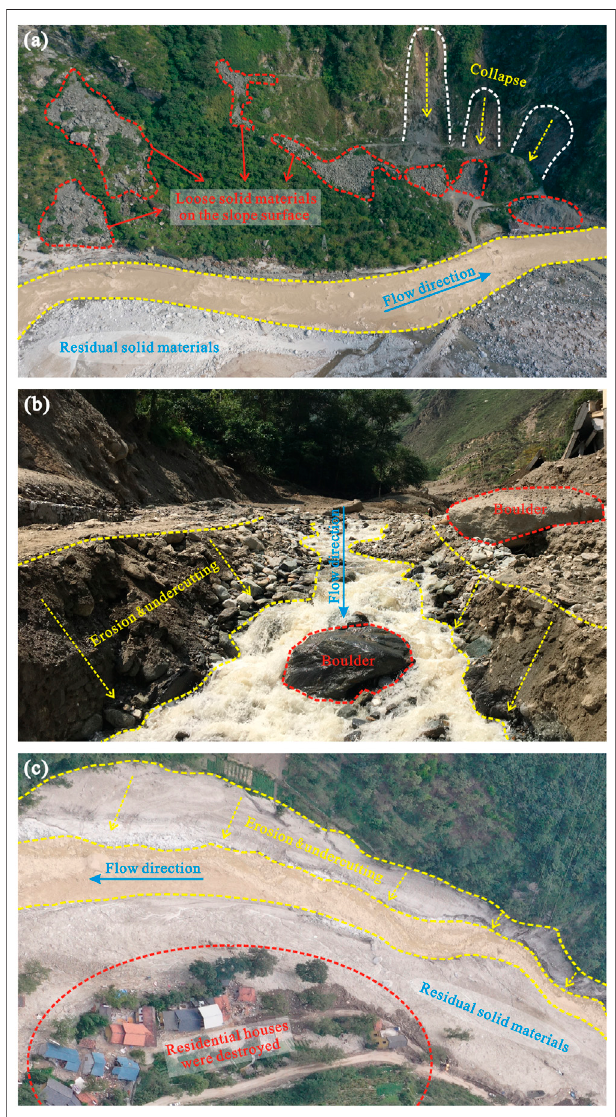
FIGURE 7 | Typical traces left behind by the “ 8 · 20 ” clustered debris fl ows event: (A) loose solid materials on the slope surface and in the gully; (B) thedepositsandterraceswerestronglyundercutandlaterallyeroded;and (C) buried residential houses along the bank of Cutou Gully.